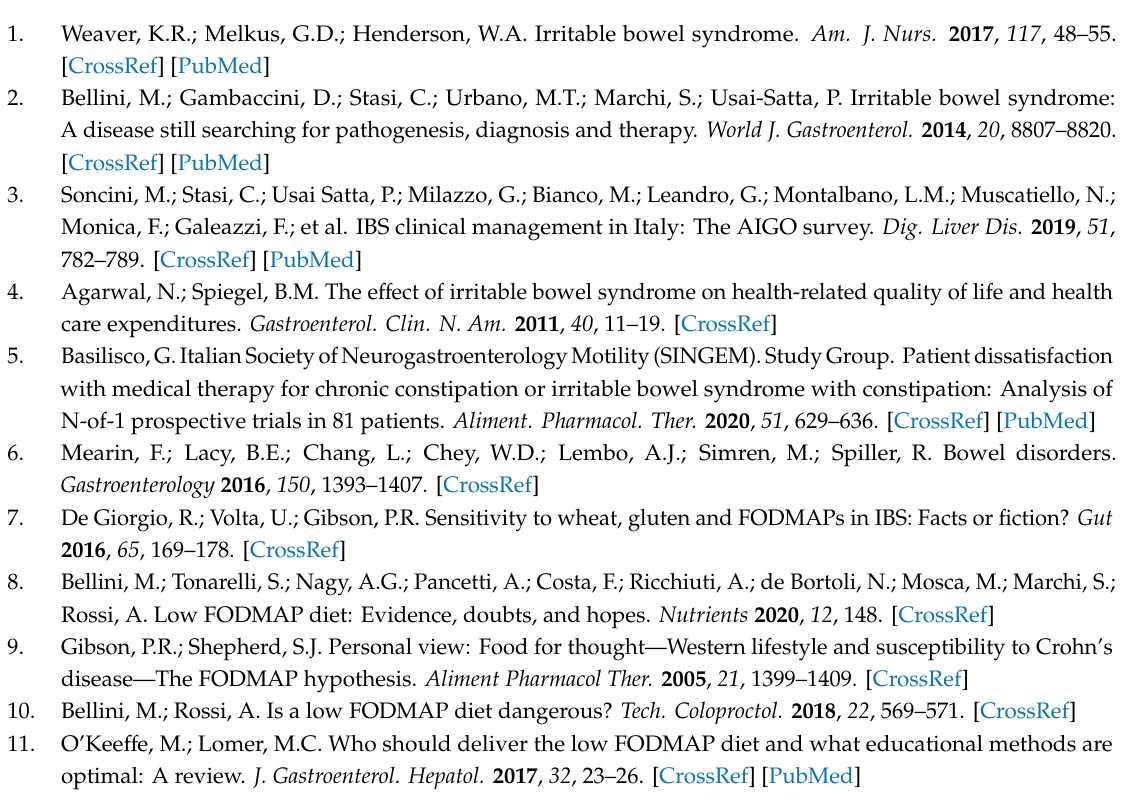
TableS1: DietaryAcceptabilityQuestionnaire, TableS2: Food-relatedQOLquestionnaire, TableS3: Anthropometric data of IBS patients at T0, T1 and T3, Table S4, IBS-Symptom Severity Score results at T0, T1, T2 and